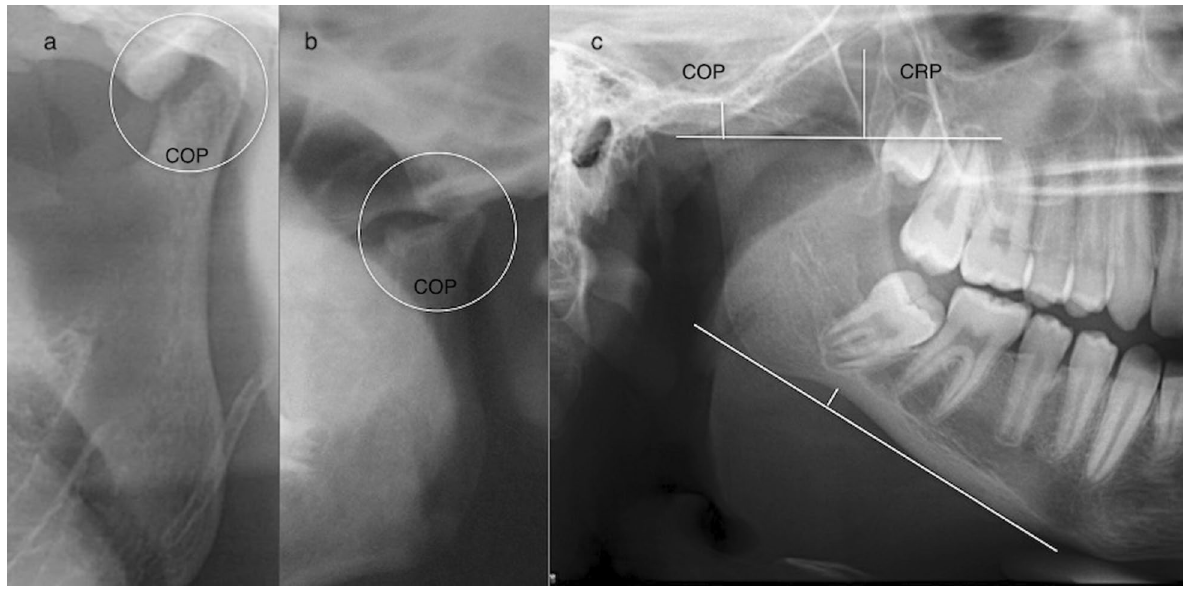
Fig. 1 a demonstrated the erosion in mandibular head; b totally disform mandibular head; and c the depth of the curvature of the antegonial notch and the disproportion between the height of the condylar process (COP) and the coronoid process (CRP)